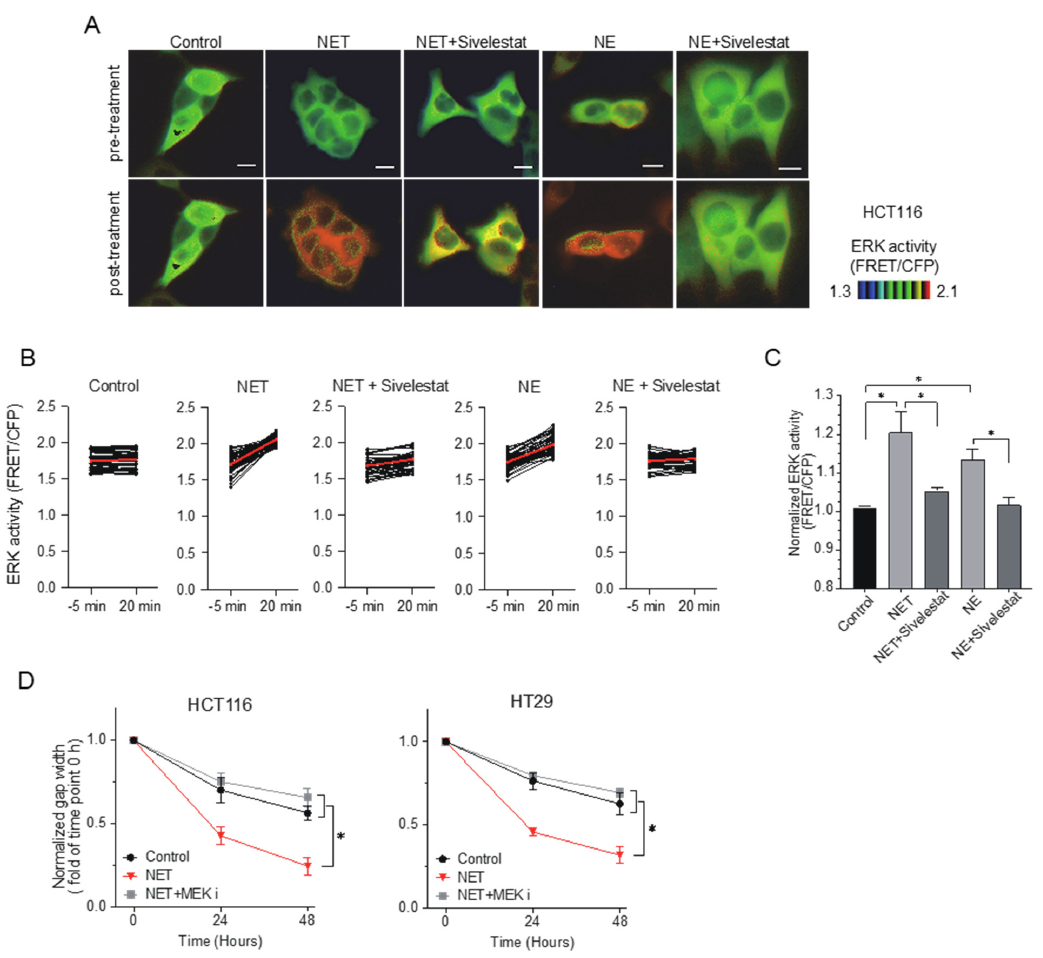
Figure 3. Extracellular signal-regulated kinase (ERK) is an important regulator of activated cell migration induced by NETs. ( A ). Förster resonance energy transfer (FRET)-based live cell imaging using the biosensor of ERK in HCT116 cells. HCT116 cells were serum-starved for 6 hours. Cells incubated with NET-CM were treated with 10 µ g/mL of NE or 100 µ M of sivelestat. Representative FRET/CFP ratio images of pre-/post-treatment are shown in the intensity-modulated display mode. Scale bars, 10 μ m. ( B ). ERK activity (FRET/CFP) of pre-/post-treatment in HCT116 cells. Each dot represents the ERK activity of each cell. A total of 54 cells were analyzed. Red bars indicate the mean values. ( C ) Increased rates in normalized ERK activity (FRET/CFP) of HCT116 cells before and after the addition of NET-CM. Results are presented as the means ± SEM of triplicate measurements. * p < 0.05 with Student’s t -test. ( D ). HCT116 and HT29 cells incubated with NET-CM were treated with 10 nM of mitogen-activated protein kinase kinase (MEK) inhibitor. Wound width was measured at 0, 24 and 48 hours. The gap width at time 0 was normalized to 1. Mean: bars ± SD. n = 3. * p < 0.05 with Student’s t test.